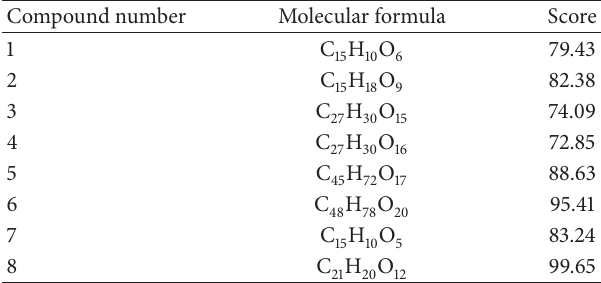
Figure 3: The detailed LC-MS signals of peaks at specific mass-to-charge ( 𝑚/𝑧 ) ratios 287.1 (a), 343.1 (b), 595.2 (c), 611.1 (d), 885.5 (e), 975.5 (f), 271.1 (g), and 465.1 (h). Of each panel, signal of the Sanjin Tablets compound was presented at the lower position, and the control signal was presented at the upper position.